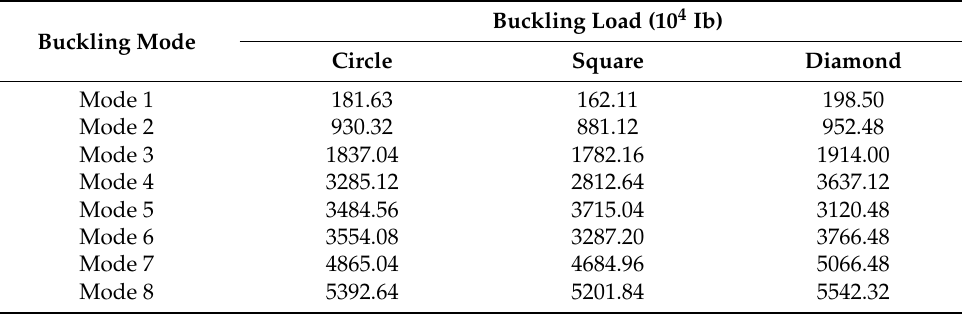
Table 2. The critical buckling load for different buckling modes of the FGM